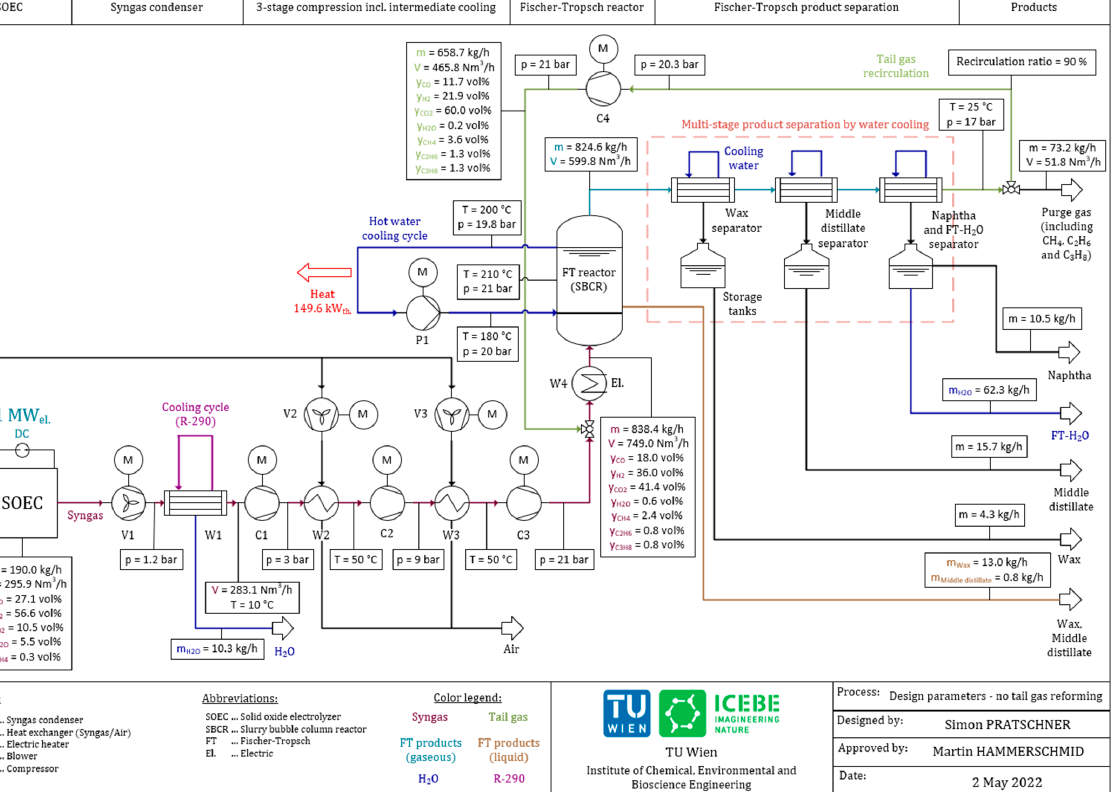
Figure 5. Design parameters of the plant configuration without tail gas reforming.